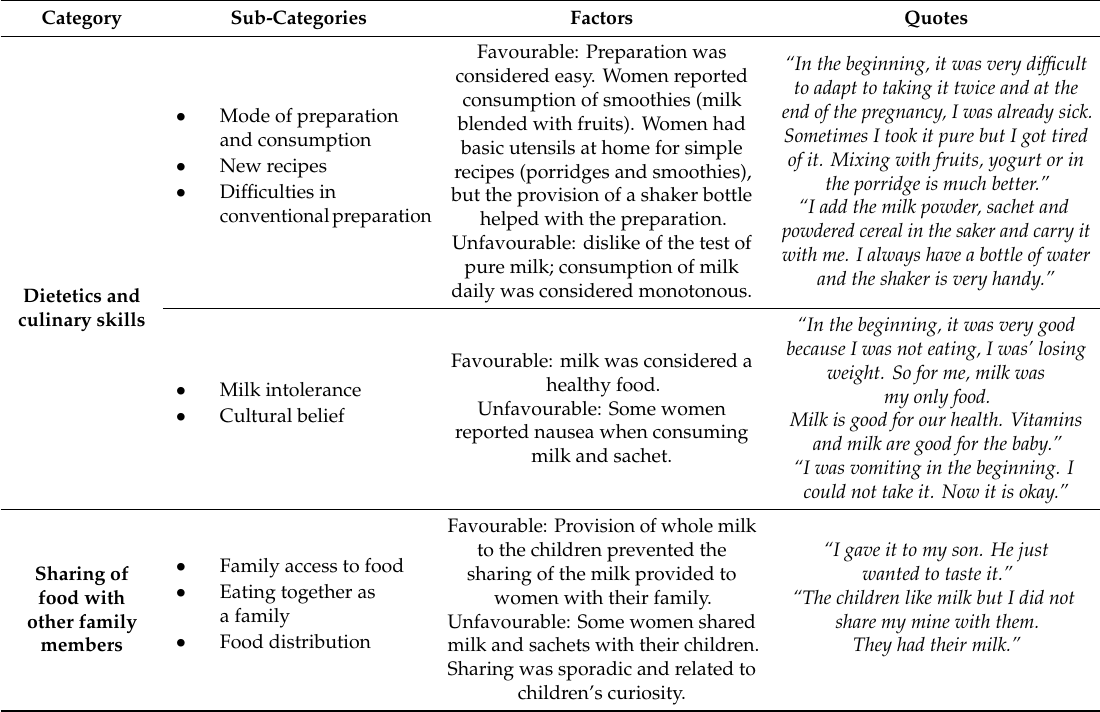
Table 4. Quotes related to the content included in the matrix.